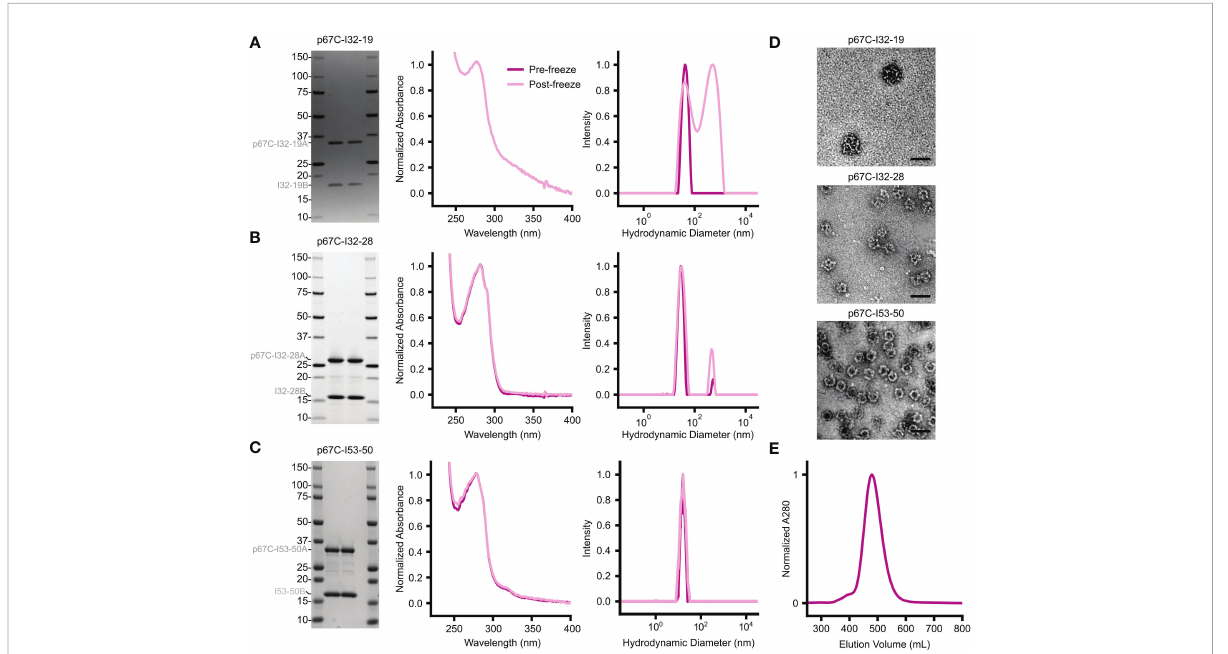
FIGURE 6 Biophysical characterization of in vitro -assembled two-component nanoparticles displaying p67C. (A – C) From left to right, SDS-PAGE, UV/vis absorbance, and DLS data are provided for (A) p67C-I32-19, (B) p67C-I32-28, and (C) p67C-I53-50. The left and right lanes for each nanoparticle are samples pre- and post-freeze/thaw, respectively. The DLS data for p67C-I32-28 and the DLS and UV/vis data for p67C-I32-19 suggest the presence of aggregates. (D) Negatively stained electron micrographs are shown for each nanoparticle immunogen after puri fi cation by SEC. (E) Preparative SEC of a >100 mg batch of p67C-I53-50 nanoparticle on a Superose 6 prep grade XK 50/60 column yielded a single, symmetric peak corresponding to the nanoparticle